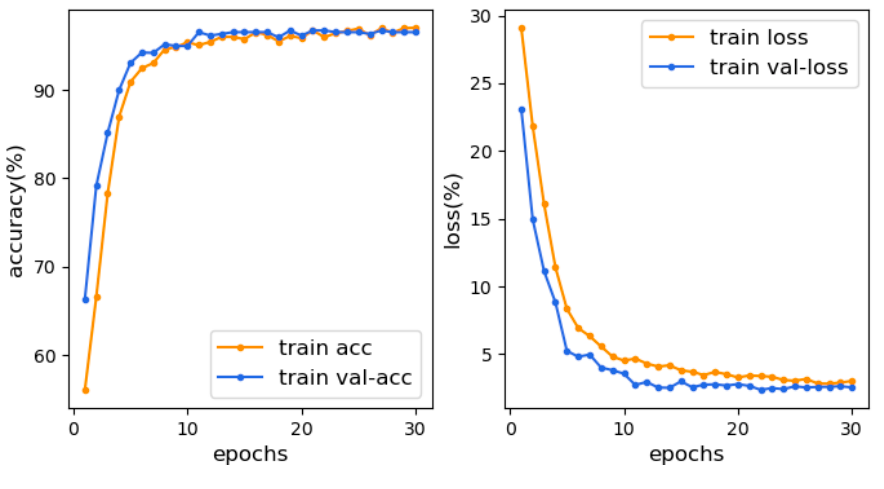
Figure 11. Training results.